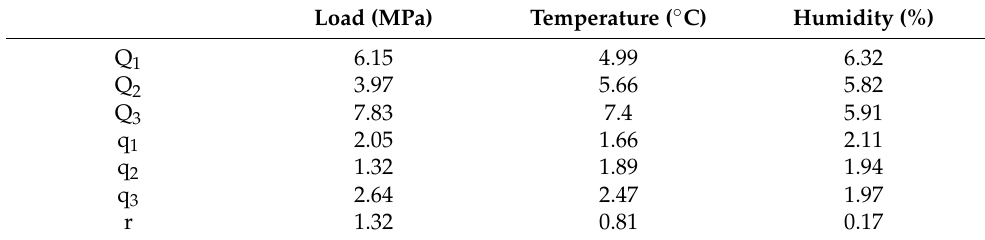
Table 3. Creep strain range analysis.